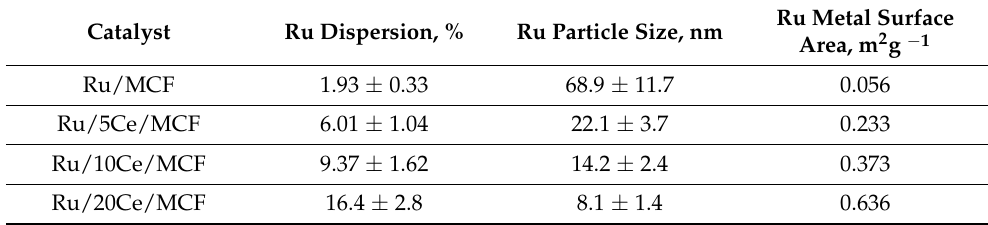
Table 4. Ruthenium dispersion in the presented